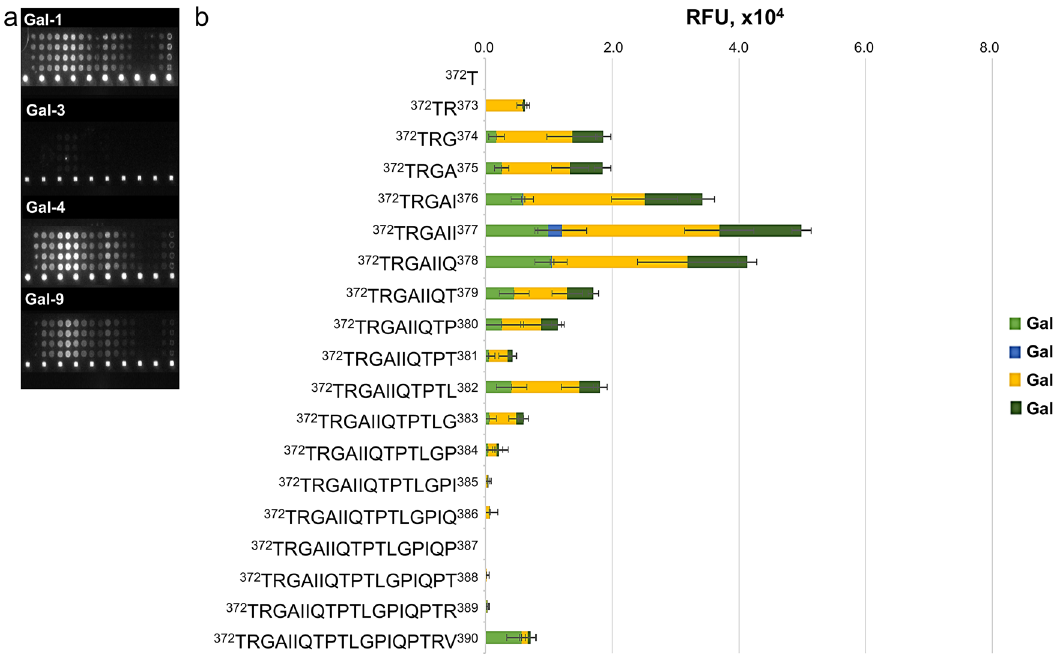
Figure 4. Fluorescence image of microarray chip of α-DG unglycosylated peptide library taken after treatment with 10.0 μg/mL galectin solution ( a ). Stacked chart of signal intensities of 200 μM unglycosylated peptide of α-DG library with 3.20 μg/mL Gal-1, -3, -4, and -9 ( b ). The relative interaction of 200 μM α-DG unglycosylated peptides with 0.10 μg/mL to 32.0 μg/mL Gal-1, -3, -4, and -9 is in Supplementary Fig. S7. p =